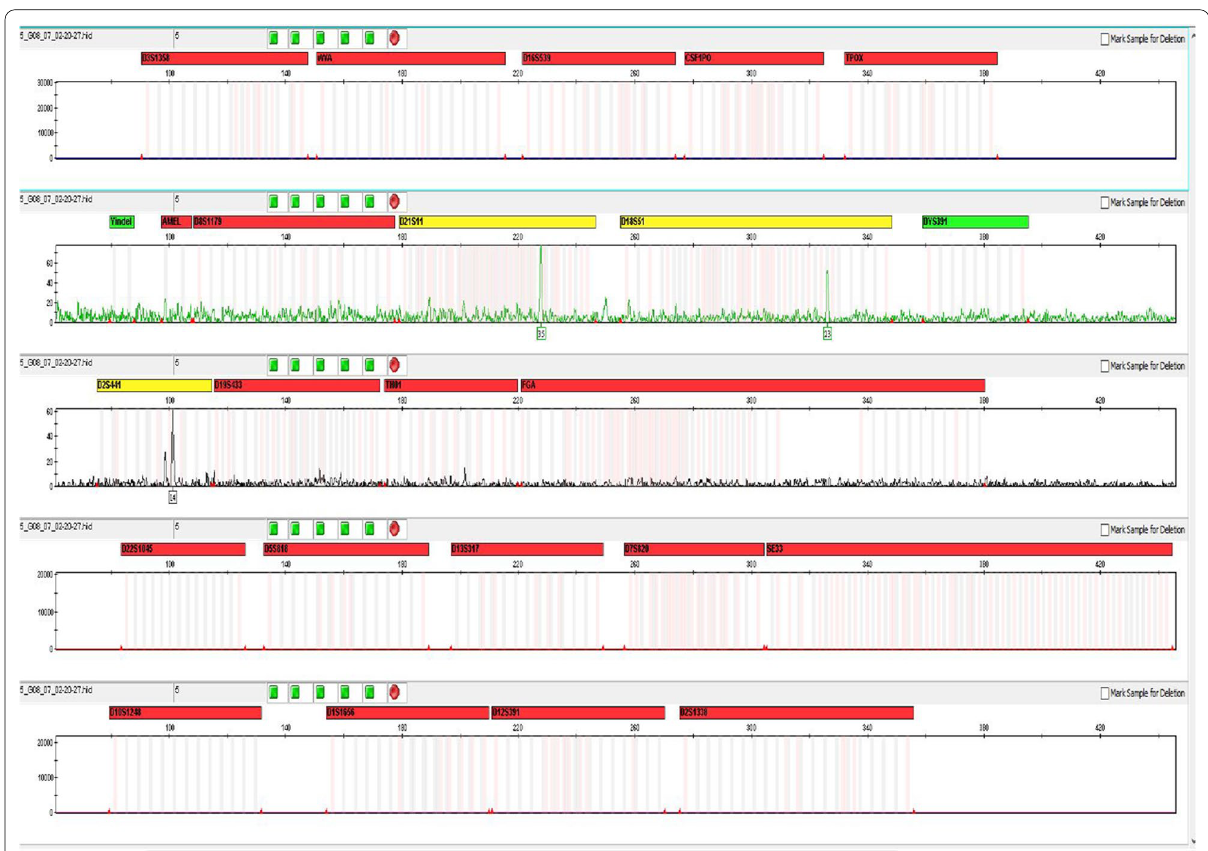
Fig. 9 DNA partial profile of blood stain in washed cotton fabric at 90 °C extracted by spin colon-based extraction method (QIAamp DNA Mini